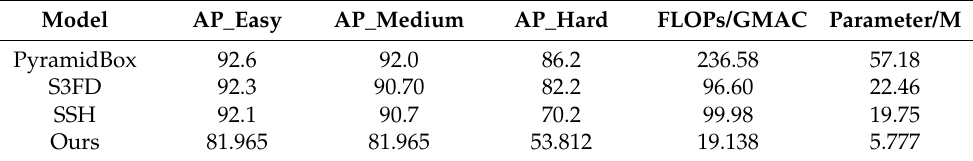
Table 3. Comparison of different models on the WIDER FACE dataset.